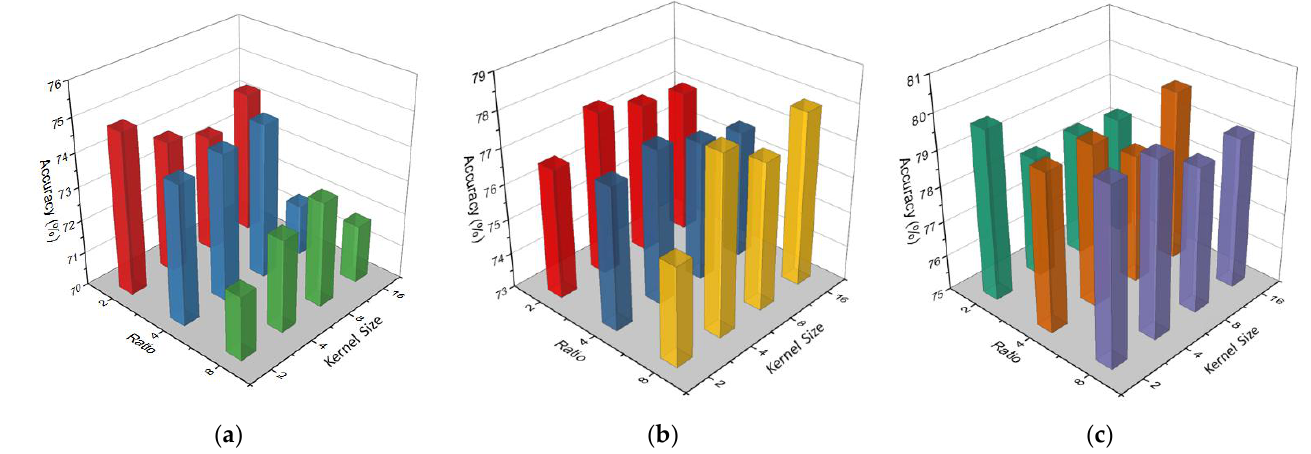
Figure 9. Accuracy comparison between different kernel sizes and ratio in CBAM block on EEGNet Block 1 ( a ), EEGNet Block 2 ( b ), and EEGNet Block 3 ( c ).